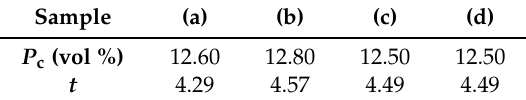
Table 2. Parameter values of the percolation model for samples shown in Figure 4.